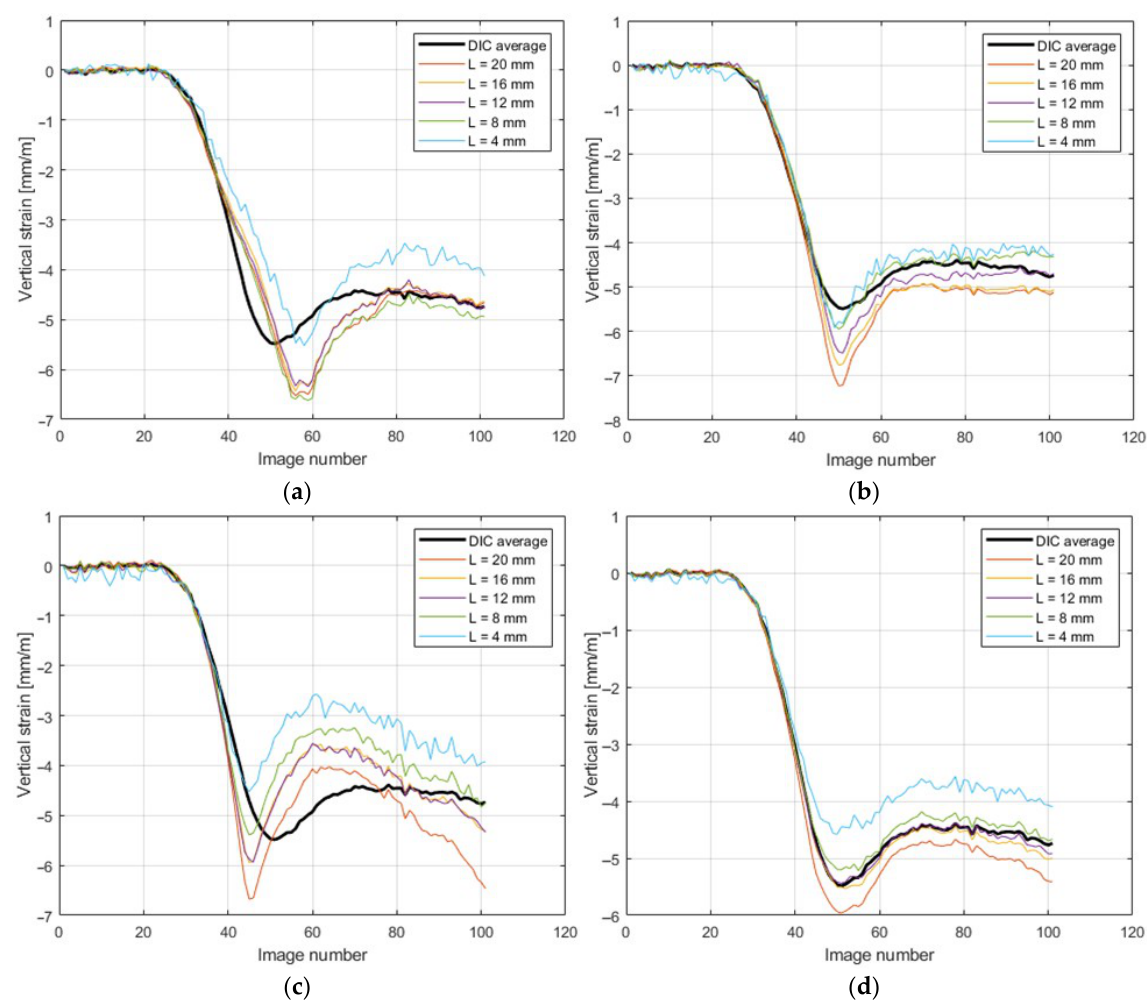
Figure 12. Comparison of strains measured by different lengths of virtual gauges with DIC measurements. ( a ) left set; ( b ) mid set; ( c ) right set; ( d ) averaged.